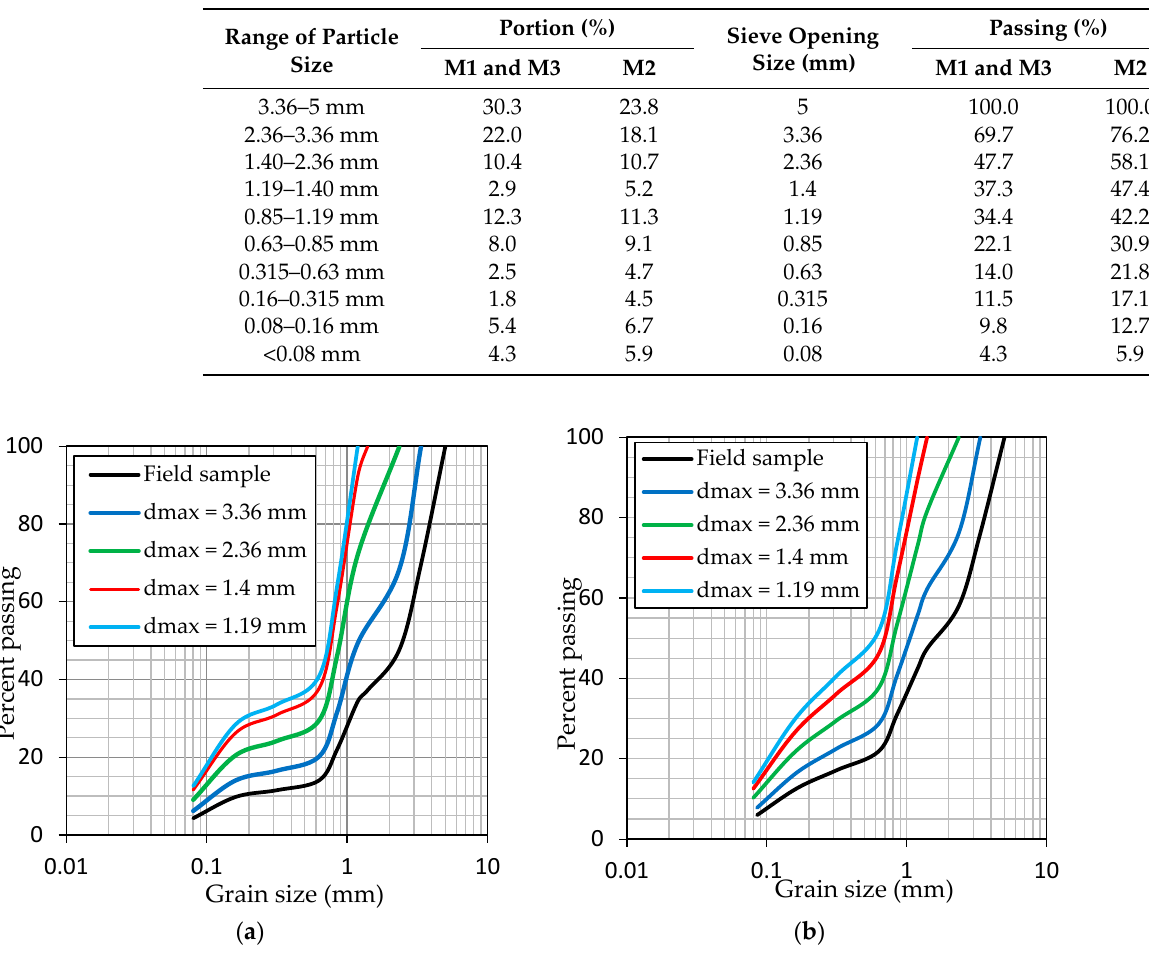
Table 1. Portion distributions of field samples M1, M2 and M3.